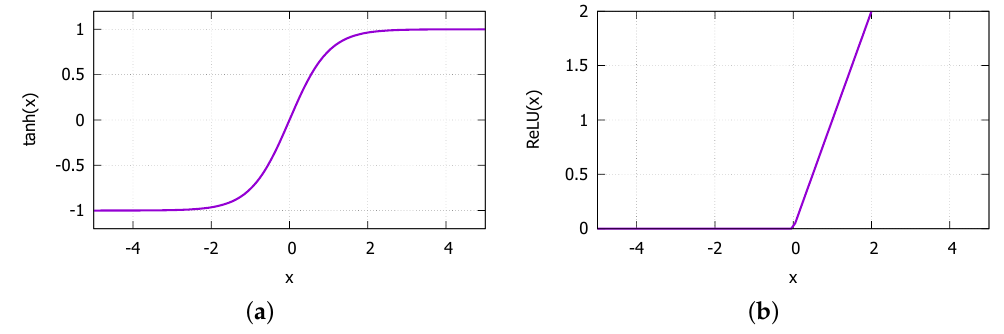
Figure 10. Activation functions: ( a ) hypertangent (tanh) used for hidden layers; ( b ) rectified linear unit (ReLU) activation function used for the output